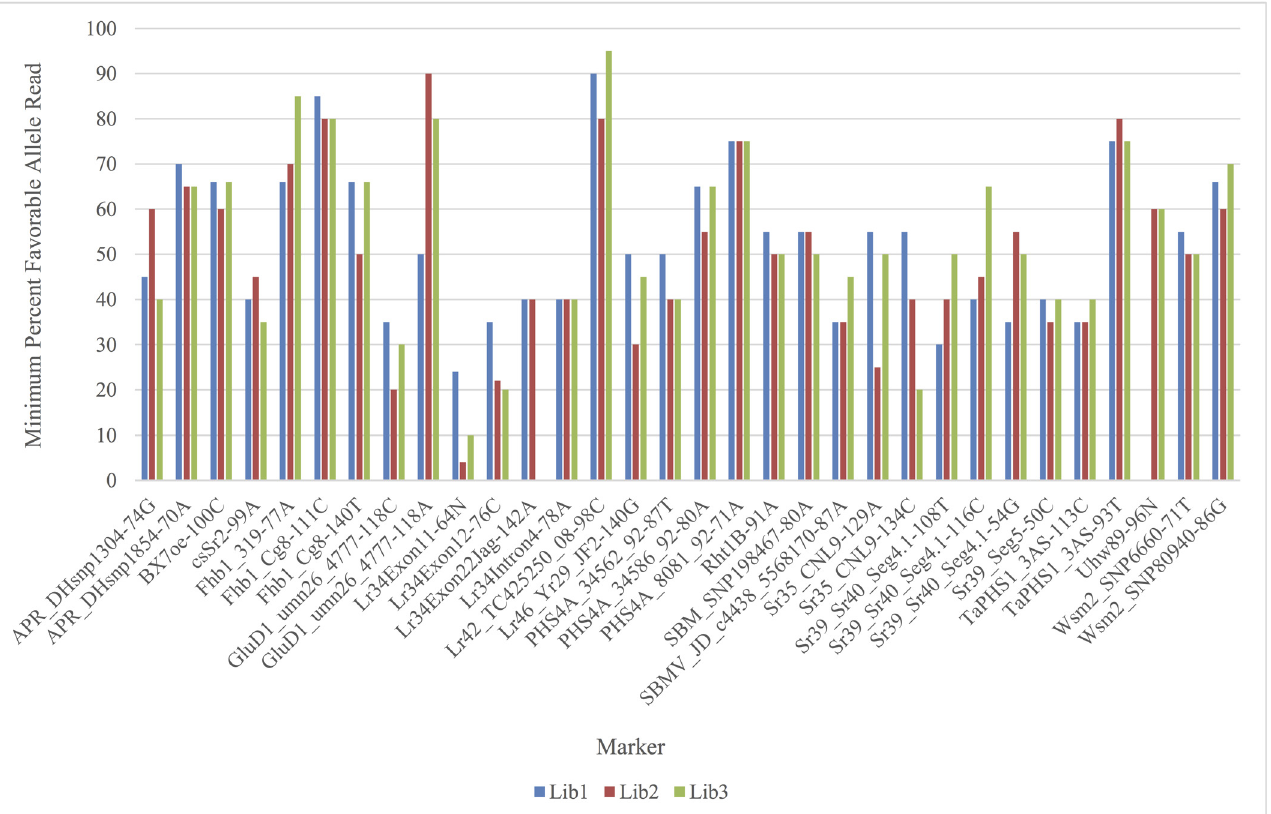
Fig 7. Minimum percentage of favorable allele reads from three GBMAS libraries constructed using the 2-tier primer pool of 8 nM and 16 nM primers and non-TD PCR.